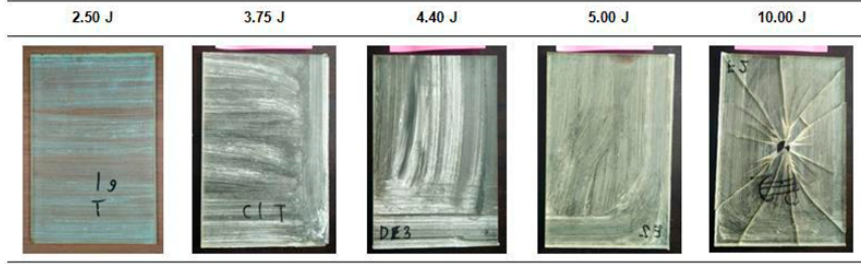
Figure 8. The EP samples after low velocity impacts at different impact energy levels.